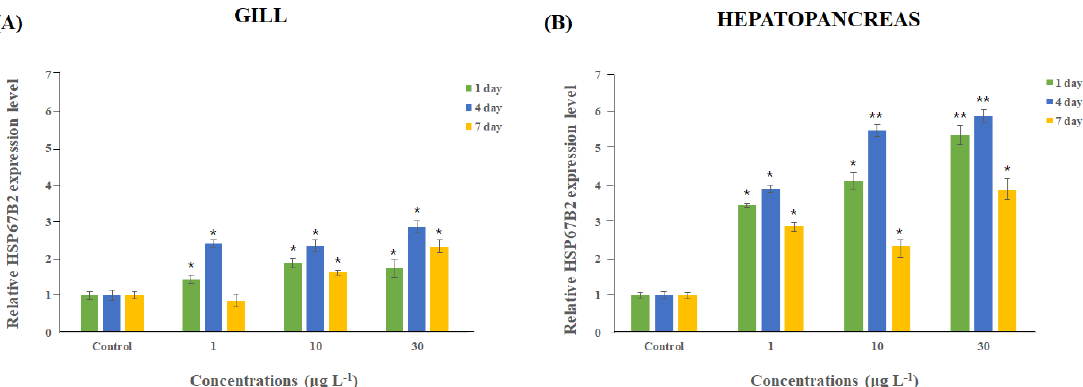
Figure 5. Expression analysis of HSP67B2 in the ( A ) gill and ( B ) hepatopancreas of Macrophthalmus japonicus exposed to 1, 10, and 30 µ g L − 1 DEHP for 1, 4, and 7 days. The values were normalized against GAPDH . Bars indicate the standard deviation of the mean. Statistically significant differences are represented by asterisks as * P < 0.05 and ** P < 0.01 as compared to controls (control ratio value = 1).